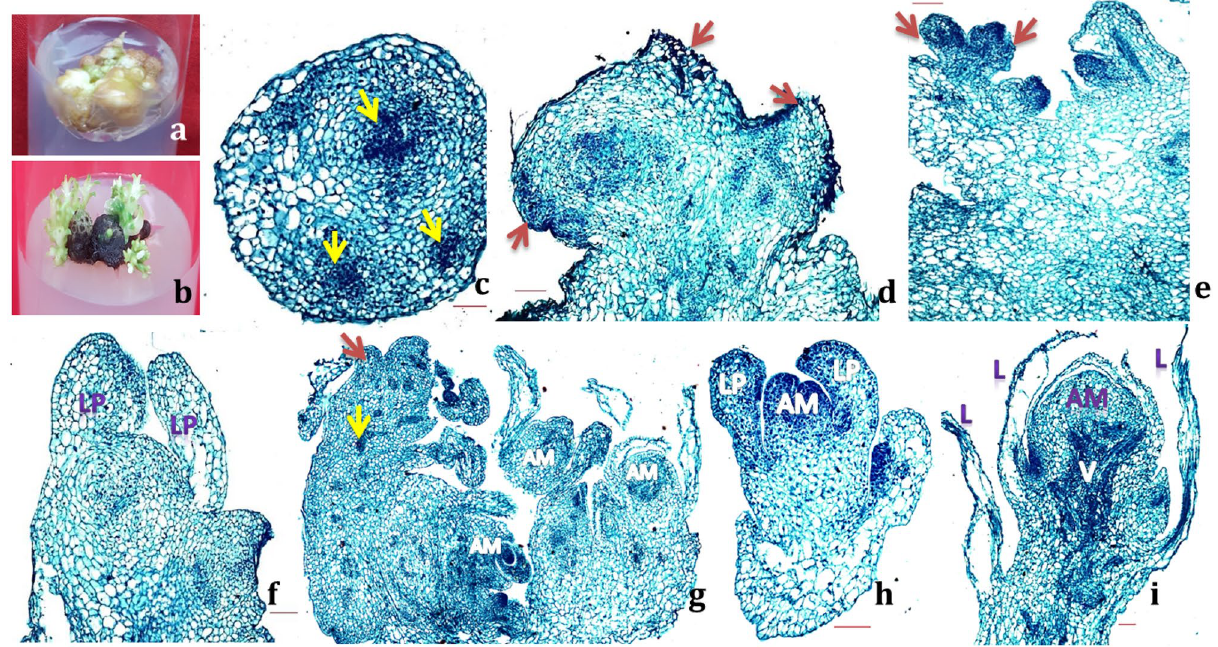
Figure 3. Histological evaluation of in vitro regeneration of Xanthosoma sagittifolium (Scale bar = 100 μm); where ( a ). pre-meristematic nodules ( b ). shoot organogenesis ( c ). Meristem mass containing small area of dense, small cells shown by yellow arrows; ( d – e ). Pre-meristematic ( d ) and meristematic nodules ( e ) in form of small protrusions at the surface of meristematic clumps shown by red arrows; ( f ). shoot primordia with clear apical dome (AM) and leaf primordia (LP); g. meristematic clump showing different stages of adventitious shoot formation; h. growing meristem to form shoots; ( i ). adventitious shoots containing apical meristem (AM), vascular tissues (V) and leaves (L).